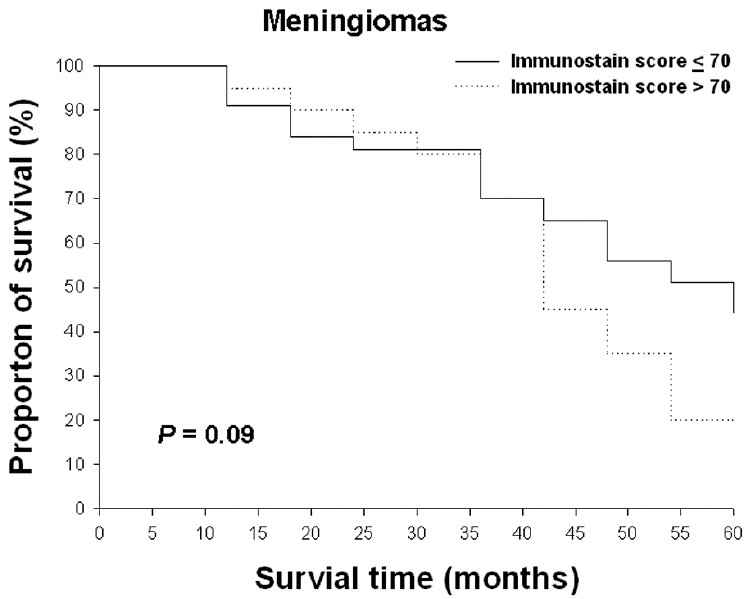
Figure 7. The relationships between the overall survival rate and Nrf2 immunostain scores in meningiomas. Survival rates were analyzed using the Kaplan–Meier survival